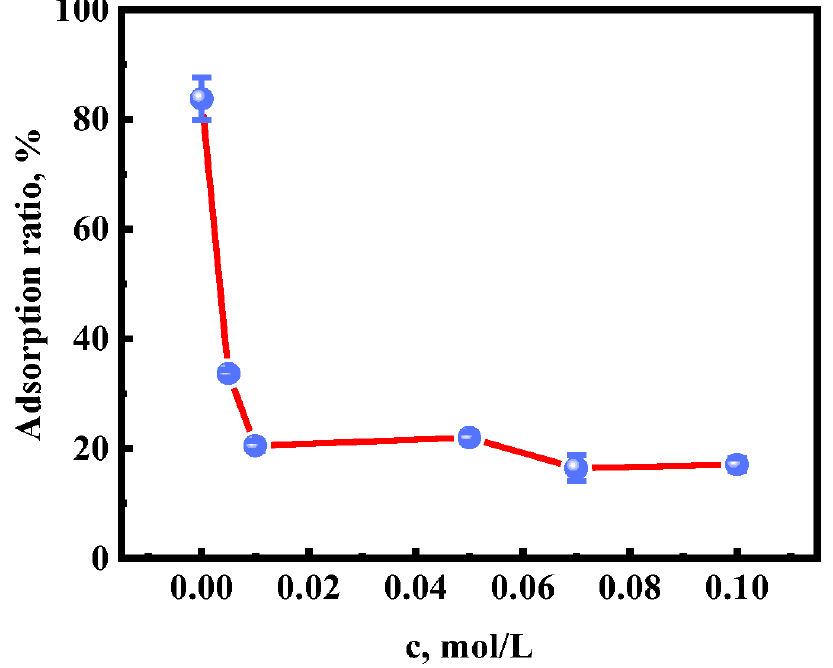
Figure 4. Effects of different concentrations of BF 4 − on Au(III) adsorption (c Au(III) = 60 mg/L, V Au(III) = 20 mL, m [HMIm]+[BF4] − @UiO-66 = 10 mg, t = 6 h, T = 35 °C, pH = 2).